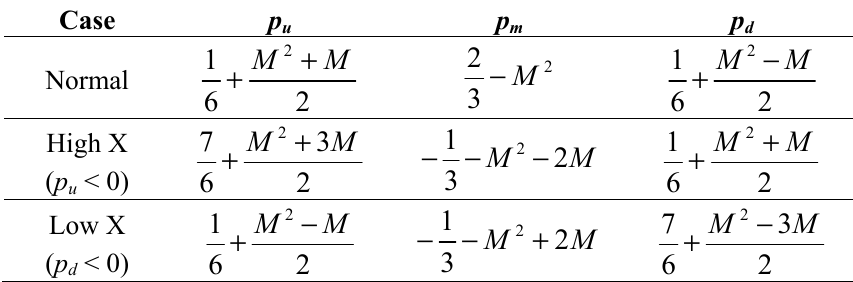
Table 13. Formulae for the probabilities in the trinomial